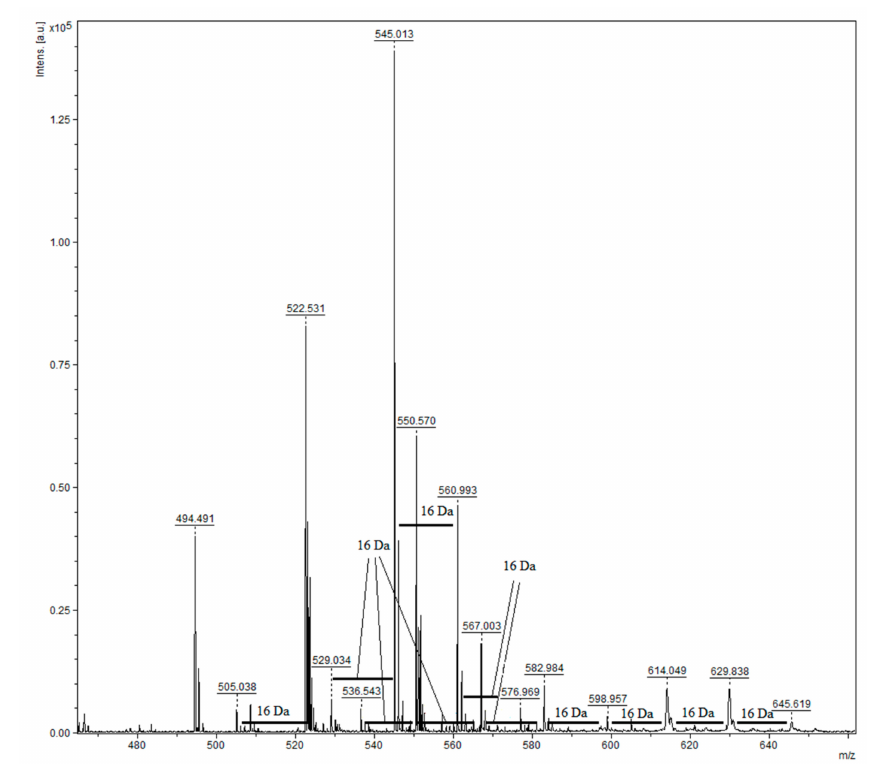
Figure 6. MALDI-TOF spectra of the insoluble-bound polyphenol from guarana powder: inset of the spectra highlighting the 16 Da increments associated with varying degrees of